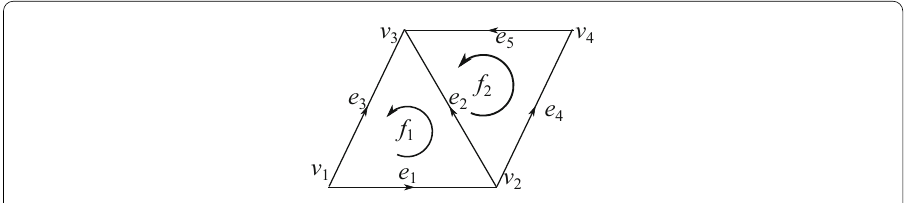
Fig. 27 Example of oriented mesh. An arrow represents the orientation of each edge and each face. The oriented face f 1 = [ v 1 ,v 2 ,v 3 ] is the equivalence class of ( v 1 ,v 2 ,v 3 ) with respect to relation (130), the oriented face f 2 is the equivalence class of ( v 2 ,v 4 ,v 3 ). The oriented edge e 1 is the equivalence class of ( v 1 ,v 2 ), etc.